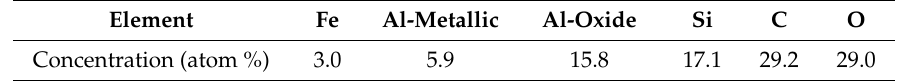
Figure 13. Bode plots of EIS spectra for different environments: ( a ) impedance modulus and ( b ) phase shift. Table 5. Chemical composition of passivation layer on FeAl20Si20 formed in the electrolyte of pH = 5.6.